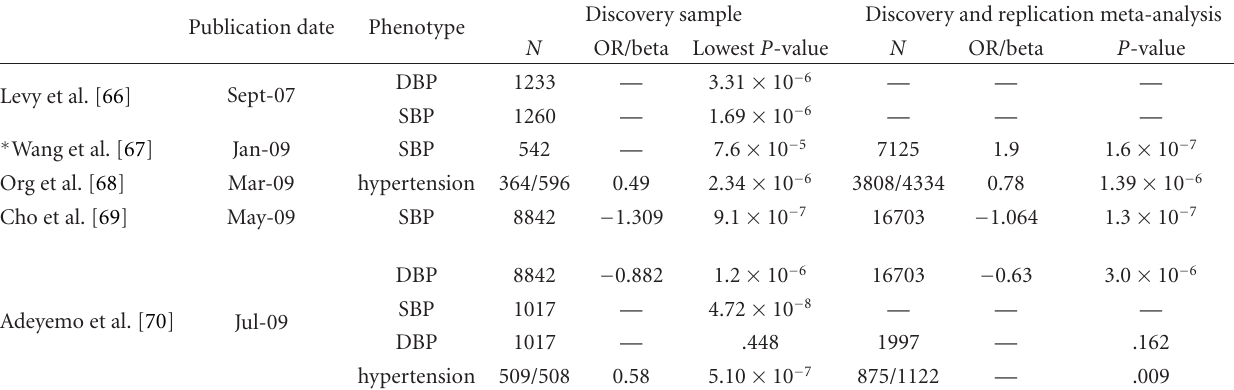
Table 1: Summary of recent GWAS of hypertension and/or blood